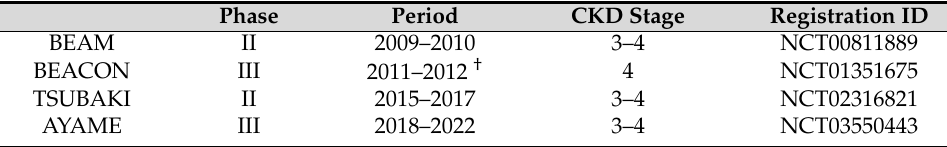
Table 3. Clinical trials investigating CDDO-ME in diabetic CKD patients.